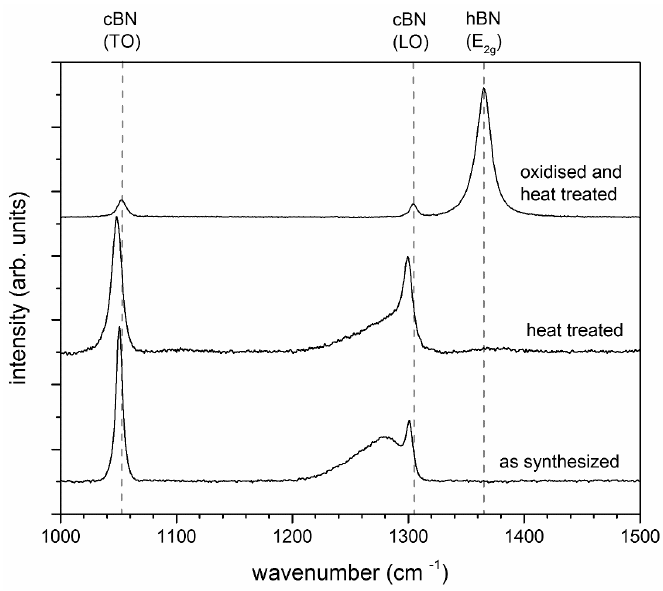
Figure 2. Raman spectra of the two heat treated c-BN powders compared to the c-BN powder as received (synthesized), showing clear differences in the transformation behavior.